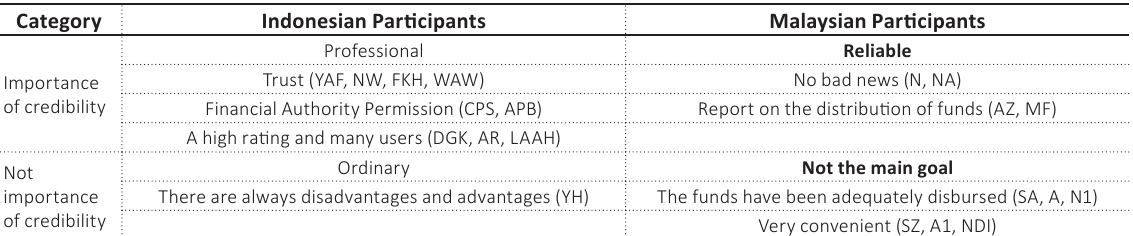
Table 4. The importance of Fintech reputation